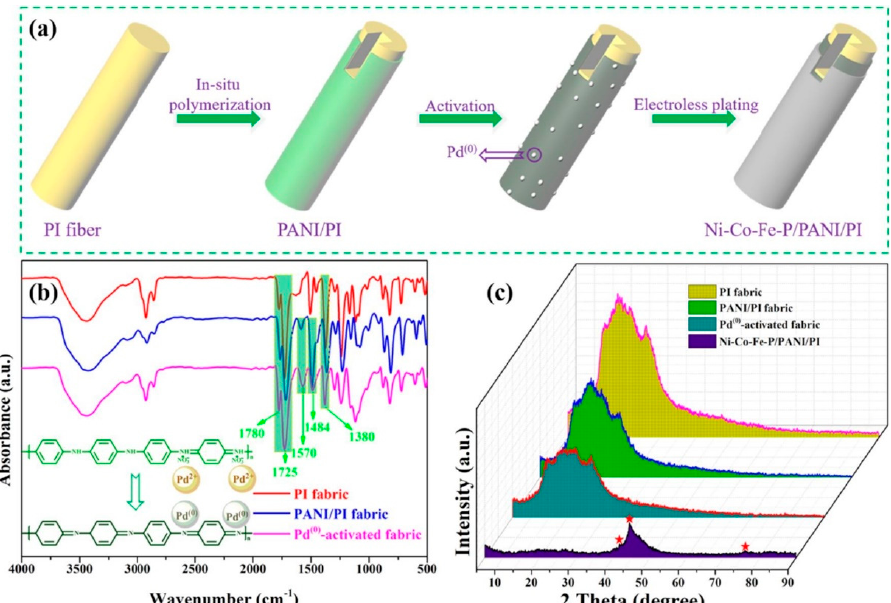
Figure 11. ( a ) Schematic diagram for the procedure of the Ni–Co–Fe–P/PANI/PI fabric. ( b ) FTIR spectra of PI, PANI/PI, and Pd (0) ‐ activated PANI/PI. Insert image shows the reduction process from Pd (II) to Pd (0) . ( c ) XRD patterns of PI, PANI/PI, Pd (0) ‐ activated PANI/PI, and Ni–Co–Fe– P/PANI/PI.Reprinted with permission from Ref. [125]. 2020, Elsevier.